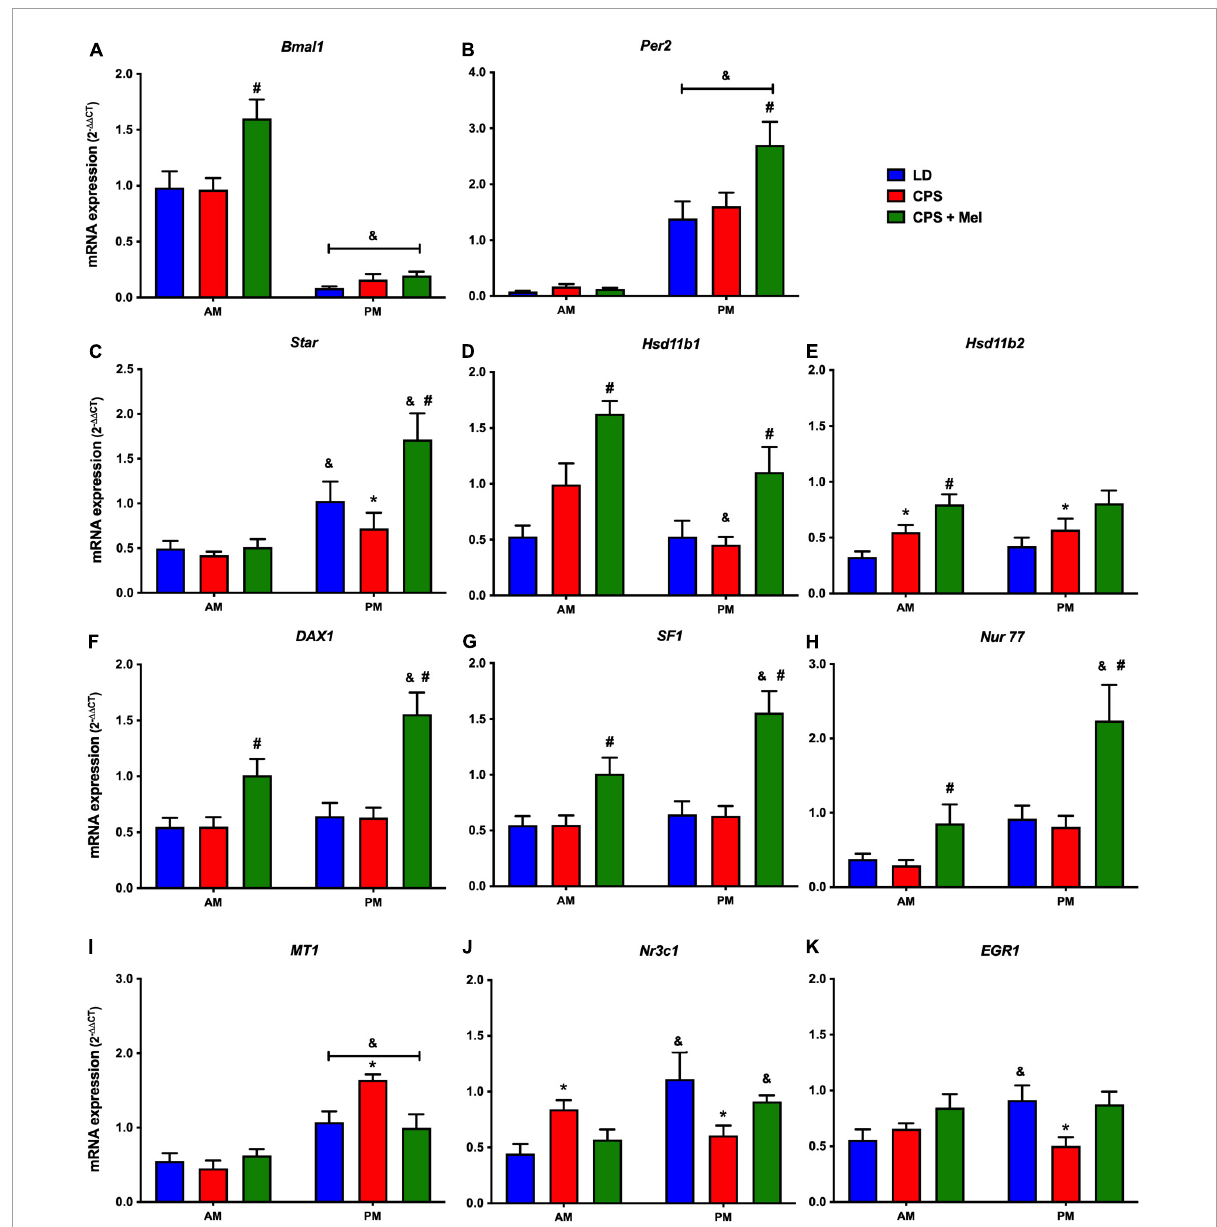
FIGURE3 Gene expression in the adrenal gland from adult female offspring. Adrenal glands were collected at 11 and 23 h ( n = 6–7 per clock time) in females gestated in LD (blue bars), CPS (red bars), and CPS + Mel (green bars) conditions. Data are mean ± SEM. *Different to LD and CPS+Mel, # Different LD to CPS (two-way ANOVA and Tukey). & Different to AM period (unpaired t -test; two-way ANOVA; and Tukey). Significant differences were ser when p < 0.05.